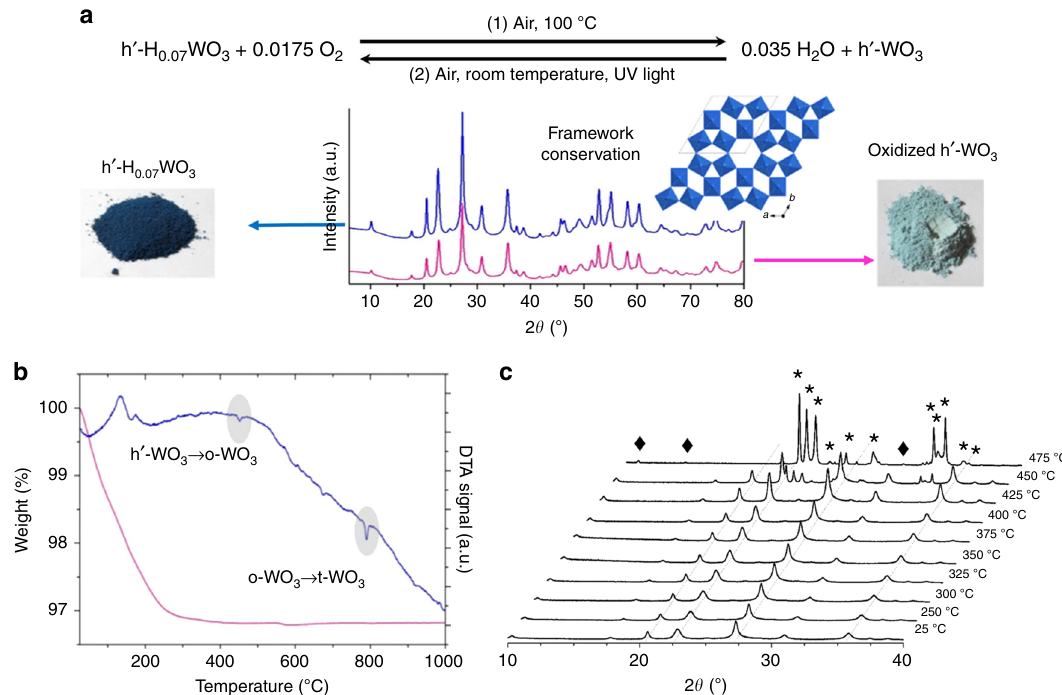
Fig. 3 Thermal stability of the new h ’ -WO 3 framework. a XRD patterns and corresponding photographs of h ’ -H 0.07 WO 3 (before thermal treatment) and h ’ - WO 3 (after heating at 100 °C under air) powders. Note that the h ’ -WO 3 appears blueish as it is shortly exposed to air in order to take the photograph, so that it already starts to reduce again. b TGA and DTA traces under air of the hydrogen bronze. c Powder XRD patterns of the heat-treated bronze as a function of the annealing temperature. Stars indicate peaks of the orthorhombic WO 3 structure, lozenges indicate peaks probably due to additional distortions in the structure. The h ’ -WO 3 framework is maintained up to 425 °C where it transforms into orthorhombic WO 3 (o-WO 3 ), then into tetragonal WO 3 (t-WO 3 ) at 780 °C ( b dissolution of the electrode materials and in which electro- tunnels and consequently to the microporosity of the material chromic tungsten oxides usually show limited stability 17 . The with short diffusion lengths for the insertion of foreign cations. N 2 sorption revealed a speci fi c surface area of 55 m² g − 1 con- electrochemical potentials used for coloration/discoloration switch were chosen to ensure reduction and oxidation reactions sistent with the dimensions deduced from microscopy (Supple- according to the cyclic voltammograms (Supplementary Fig- mentary Figure 15). This value is among the highest surface areas ure 18). First, color switching was qualitatively evidenced by reported for pure WO 3 and bronzes, especially mesoporous c- applying a square function between 0.8 and − 0.8 V vs. AgCl/Ag WO 3-x and t-WO 3 22 . A priori, h ’ -WO 3 with additional four- (Fig. 5a, b) at high frequency of 0.2 Hz. Reversible oscillations members tunnels features a more open structure than known W- between deep-blue and colorless states are observed for h ’ -WO 3 O-based compounds. It also exhibits a novel texture with easy access to the tunnels, combined with nanostructuration for (Supplementary Movie 1). These color changes suggest that the extensive exchange with the neighboring medium. This unpre- amount of protons into the h ’ -H x WO 3 bronze can be controlled by electrochemical (de)insertion. Color variations with classical cedented combination pleads in favor of fast insertion and dif- h-WO 3 are less pronounced. Bronzes of h-WO 3 with the same fusion of cations in the structure. Swift insertion/deinsertion can be combined with the white-to-blue color change upon evolution particle size give results similar to h-WO 3 . According to the I ( t ) from the stoichiometric oxide to the bronze and with the high curves (Fig. 5a, b), near-equilibrium conditions are reached upon stability of the h ’ -WO 3 framework in acidic electrolytes, in order bleaching (positive bias for oxidation) for both compounds and upon coloration (negative bias for reduction) for classical h-WO 3 . On the contrary, the equilibrium state is not reached in colored h ’ -WO 3 but proton insertion is already suf fi cient to ensure important absorbance switch. Quantitative assessment was then performed. Electrochemical measurements were coupled with in situ UV-visible measurements at a wavelength of 700 nm evaluation of aqueous electrochromic devices. The nanoscaled (Supplementary Figure 19) by using as reference similar FTO platelets were readily processed as transparent fi lms by spin electrodes, without deposited tungsten oxide. Conditions closer to coating on conductive fl uorine-doped tin oxide (FTO) substrates equilibrium were sought by applying smaller voltage steps and (Fig. 5a, b, SI). The fi lm thickness was evaluated to 80 – 100 nm lower frequency of ±0.2 V vs. AgCl/Ag and 0.009 Hz, respectively (Supplementary Figure 16), which corresponds to approximately (Fig. 5c). For comparison, a h-WO 3 fi lm was studied in the same 8 – 20 stacked nanoplatelets. For comparison, fi lms made of clas- sical h-WO 3 nanoparticles (Supplementary Figure 17) with spe- way (Fig. 5d, e). After an induction period of two cycles, absor- bance changes are stabilized (Fig. 5c – e). I ( t ) (Fig. 5c, d, top) and ci fi c surface area similar to h ’ -WO 3 were deposited. The absorbance ( t ) (Fig. 5c, d, bottom) curves show that steady-states electrochromic properties were then evaluated by using a stan- are reached at each potential plateau. The transmittance of the h ’ - dard three-electrodes cell. Because of the high stability of h ’ -WO 3 , WO 3 fi lm shows strong changes compared with h-WO 3 , varying we have focused on an acidic (H 2 SO 4 0.1 mol L − 1 ) aqueous electrolyte that imposes stringent requirements vs. possible from 95% (absorbance of 0.05 in the bleached state) to 74%